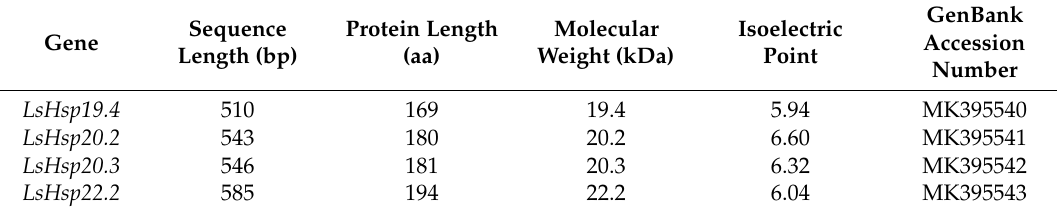
Table 2. Characteristics of sHsp mRNAs in Lasioderma serricorne .